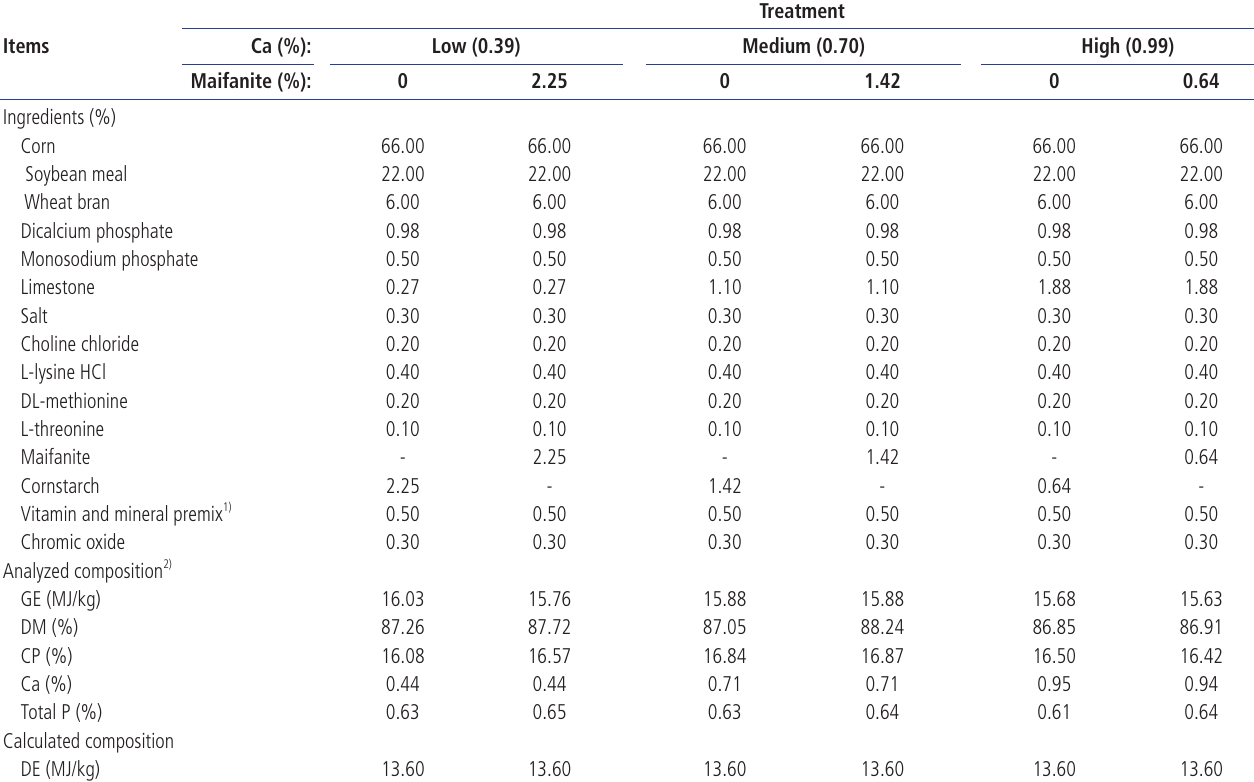
Table 1. Ingredient and nutrient composition of the experimental diets (as-fed basis)